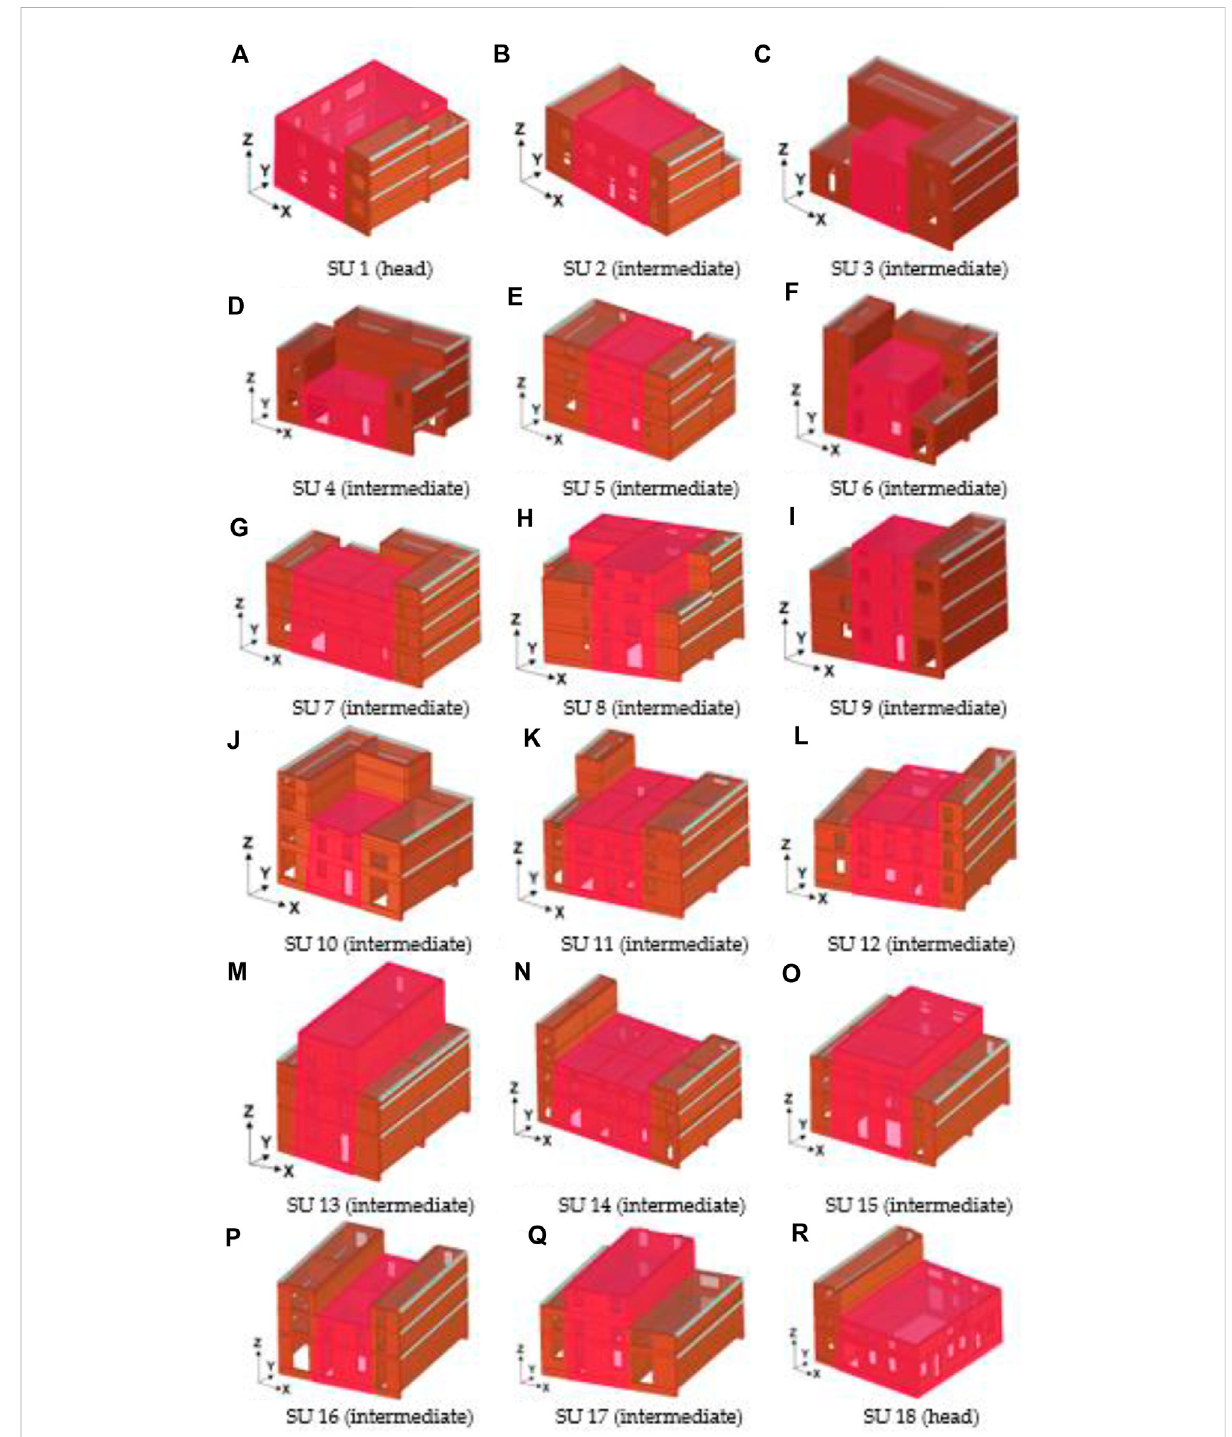
FIGURE 12 Modelling by 3Muri of aggregate SU of the building compound of